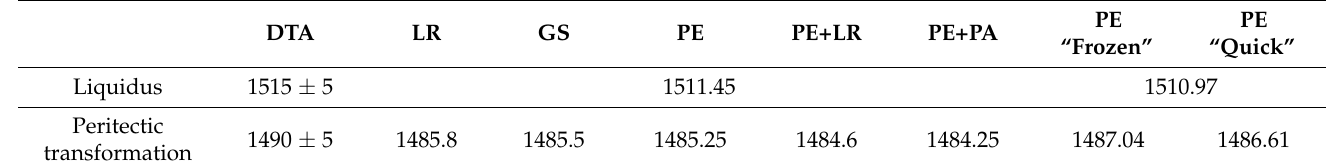
Table 1. Comparison of calculation results based on the proposed algorithm with data [12].